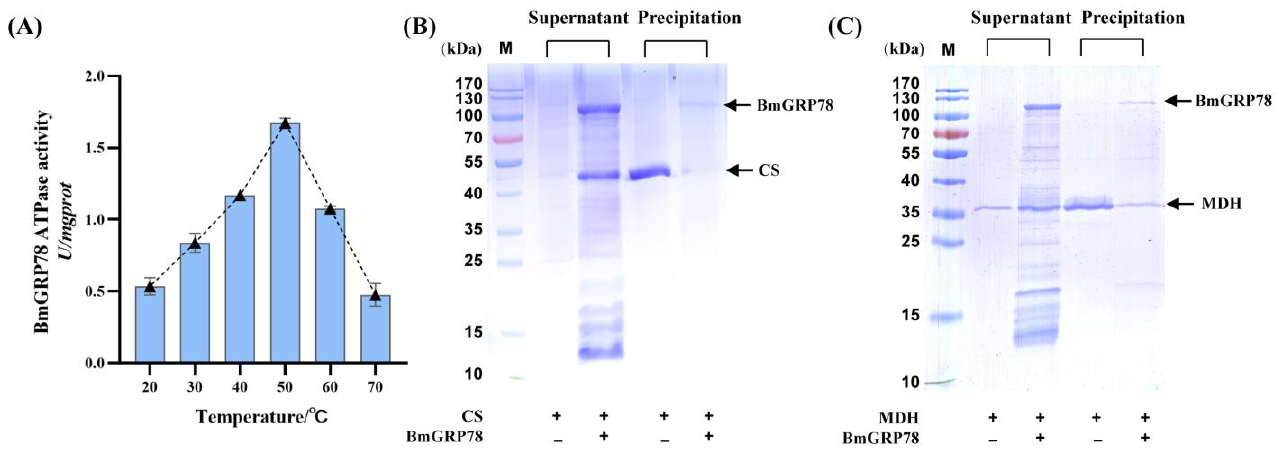
Figure 5. The ATPase activity and the prevention of the heat-induced aggregation of citrate synthase (CS) and malate dehydrogenase (MDH) by rBmGRP78 protein. ( A ) The ATPase activity of rBmGRP78 protein was measured from 20 ◦ C to 70 ◦ C. Bars represent mean ± S.E. (n = 3). The SDS-PAGE analyzed the aggregation of CS ( B ) and MDH ( C ), which was denatured for 20 min at 48 ◦ C or 45 ◦ C in the presence or absence of rBmGRP78, respectively.